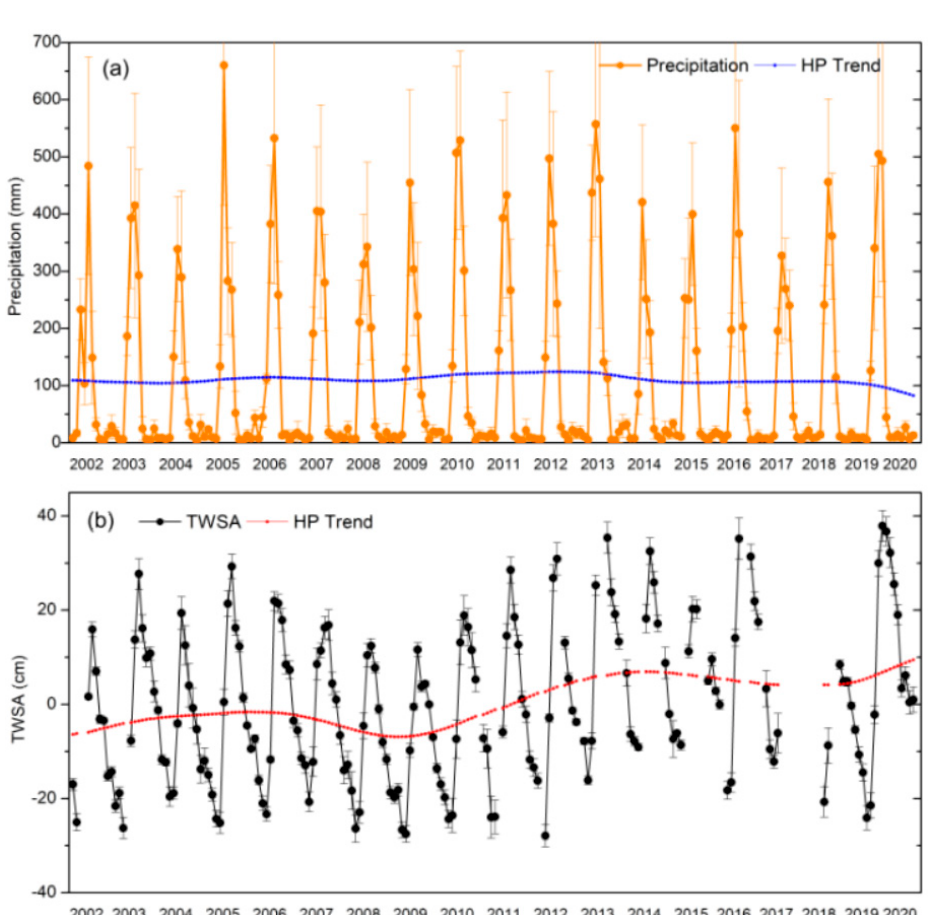
Figure 2. ( a ) Monthly mean precipitation time-series. Hodrick–Prescott (HP) trend is shown in blue color. ( b ) Monthly mean terrestrial water storage (TWS) anomaly and its HP trend in the study region.